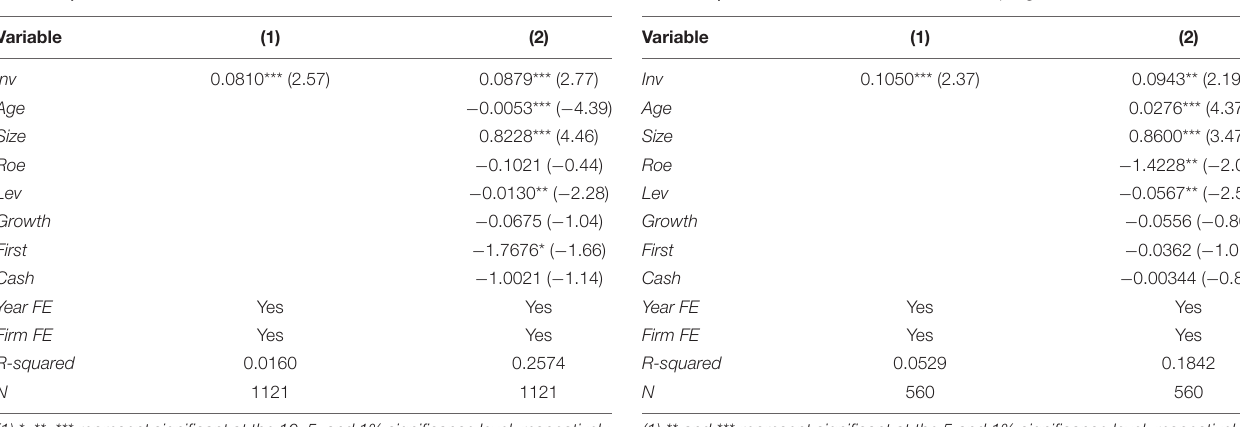
TABLE 5 | Robustness checks for alternative measure. TABLE 6 | Robustness checks for random